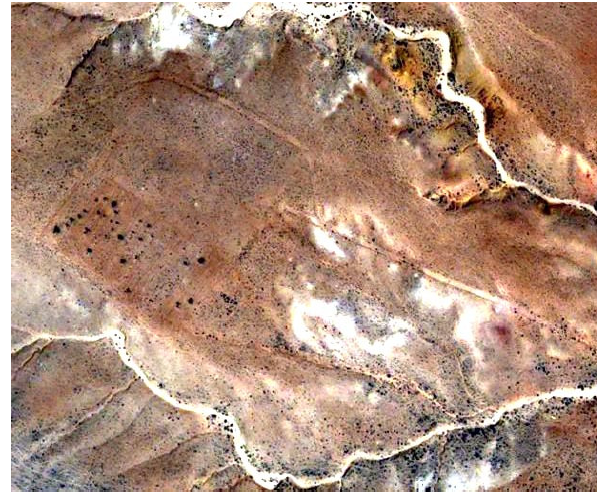
Figure 13. A Roman military camp K 1 in Ash-Shujiri, in the central area of Jebel Bishri as seen on a QuickBird satellite image.